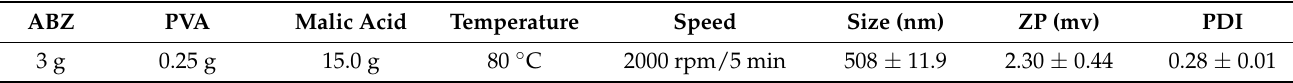
Table 1. Optimization formulation condition and properties of ABZ nanocrystal.